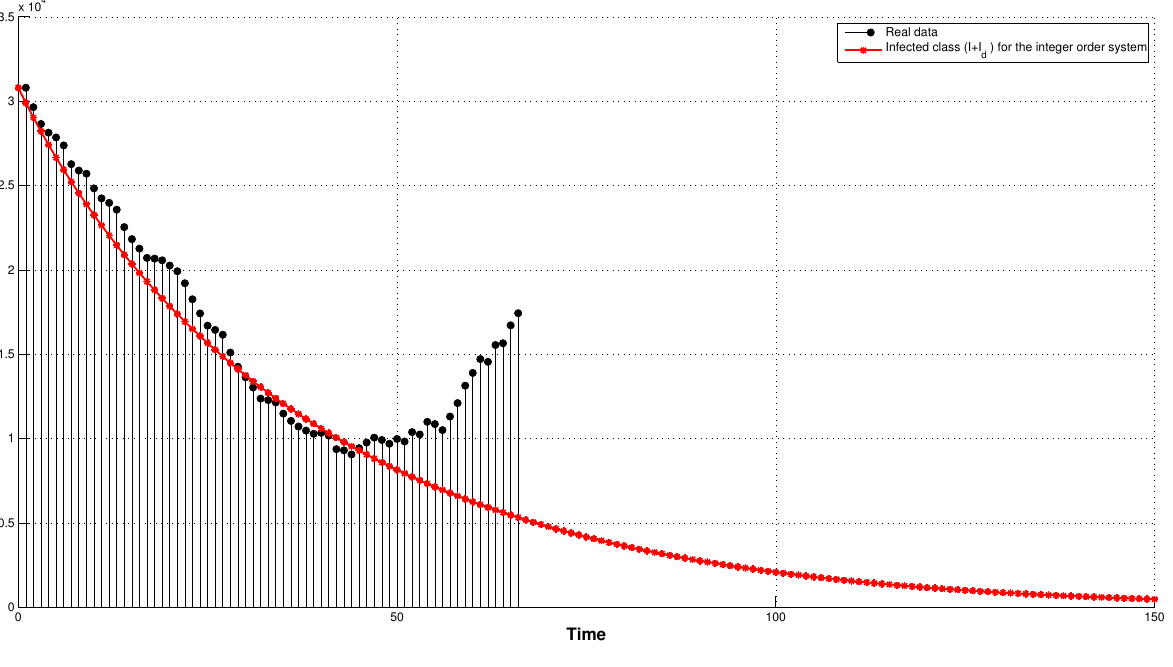
Figure 3. Numerical simulation of infected class with integer order and comparison with the real data.